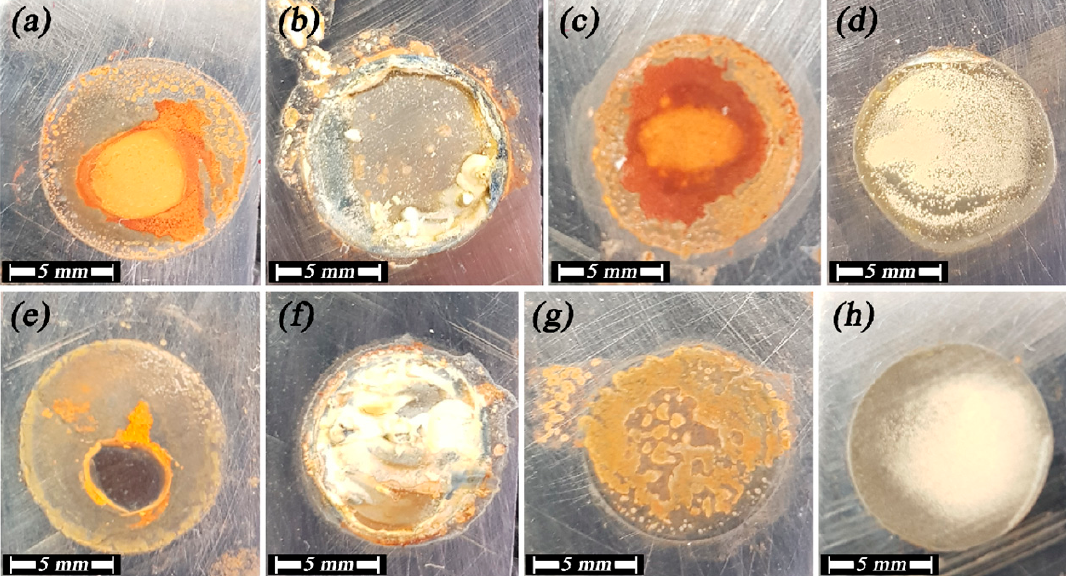
Figure 1. Visual images of mild steel after submission for 96 h: in WSS ( a ) Steel–WSS–blank , ( b ) Steel–